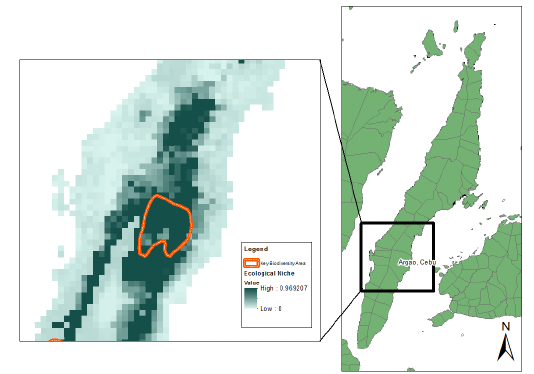
Figure 4. (A) Black shama ecological niche model